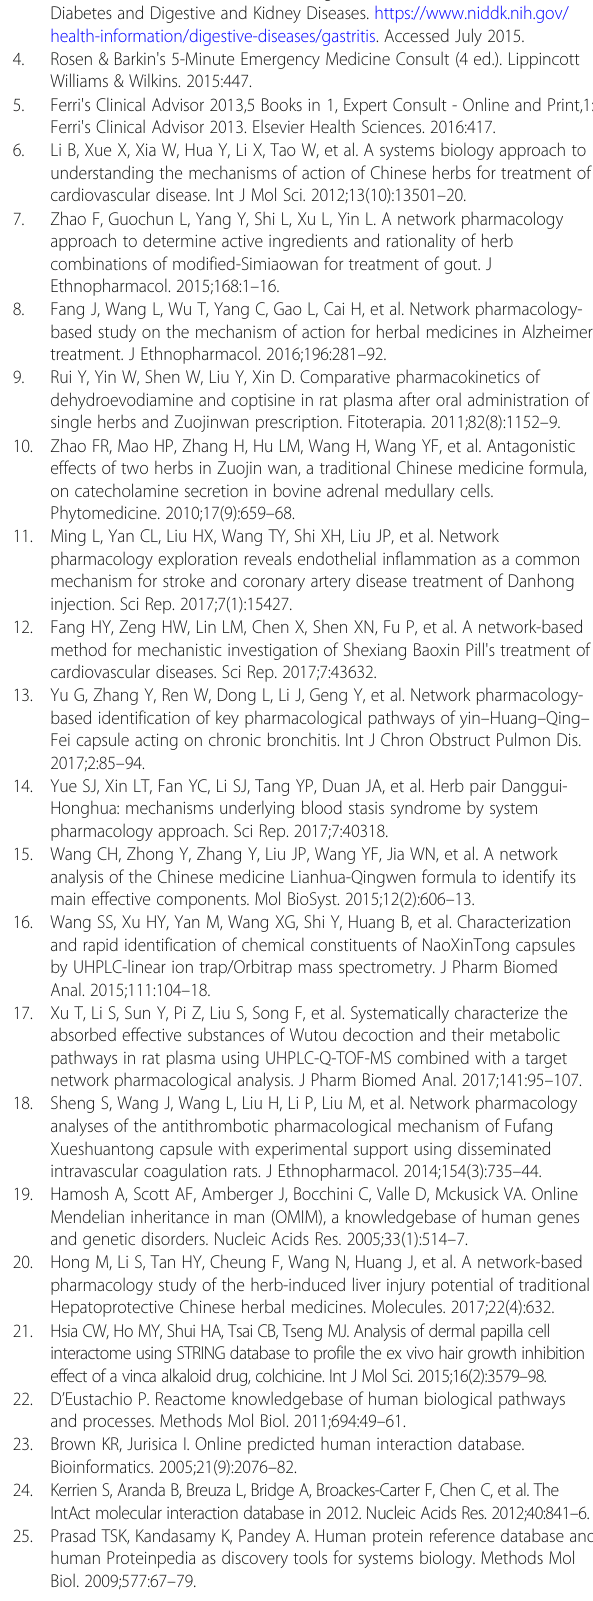
Additional file 2: Table S2. Ingredients of each herb contained in ZJW. (XLSX 1869 kb) Additional file 3: Table S3. Known therapeutic targets for gastritis. (XLSX 14 kb) Additional file 4: Table S4. Putative targets of each herb contained in ZJW and overlap between the two herbs. (XLSX 38 kb) Additional file 5: Table S5. Interactions between putative targets of ZJW and known therapeutic target for gastritis. (XLSX 474